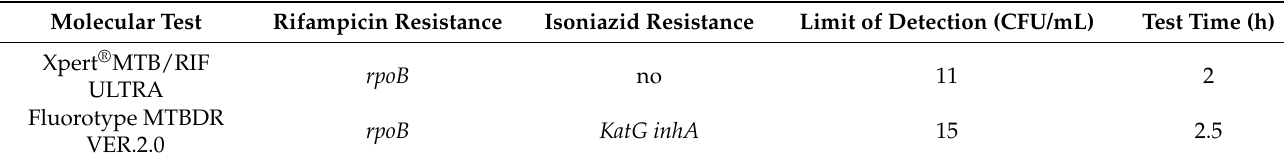
Table 1. Comparison of genetic tests for the detection of Mycobacterium tuberculosis complex. Molecular